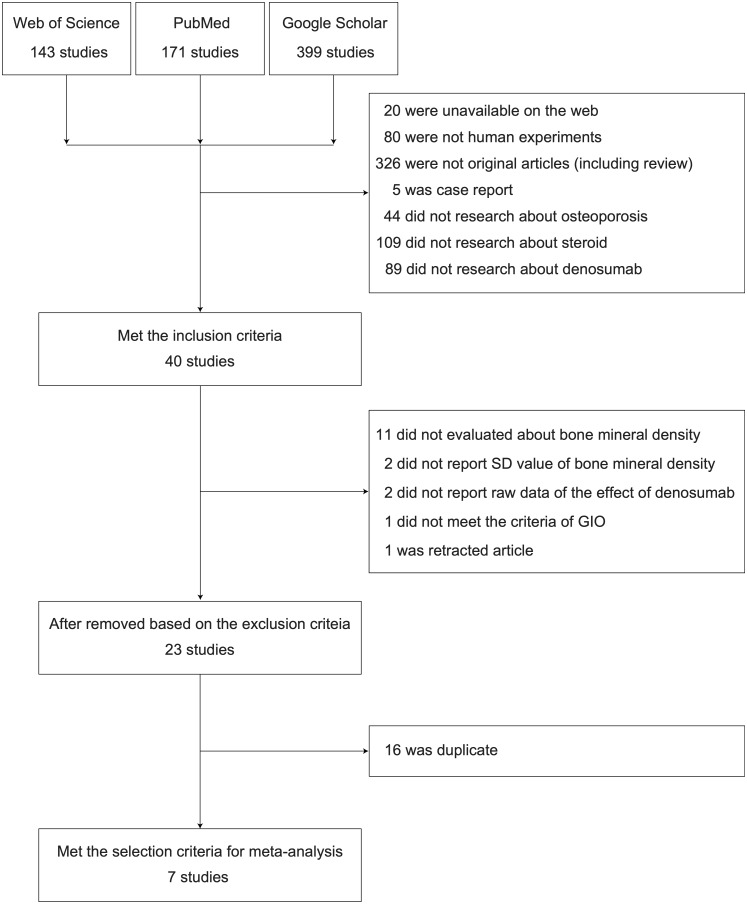
PRISMA flow diagram